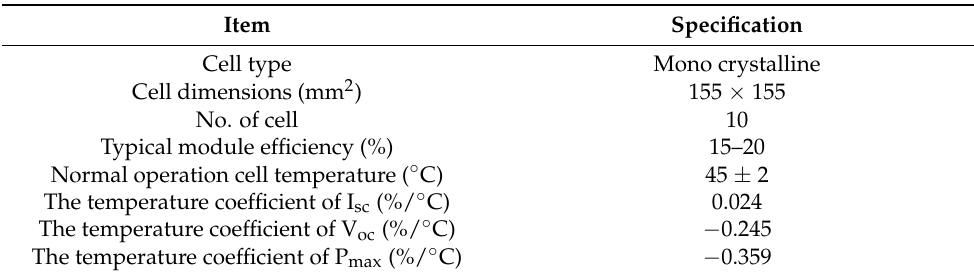
Figure 1. Shows the schematic diagram of the photovoltaic thermal (PVT) system in whole, where sub-figure ( a ) shows different parts of the PVT collector; sub-figure ( b ) is cross section diagram of the PVT collector, and sub-figure ( c ) gives details on the dimensions of the collector. Table 1. Specifications of photovoltaic (PV)